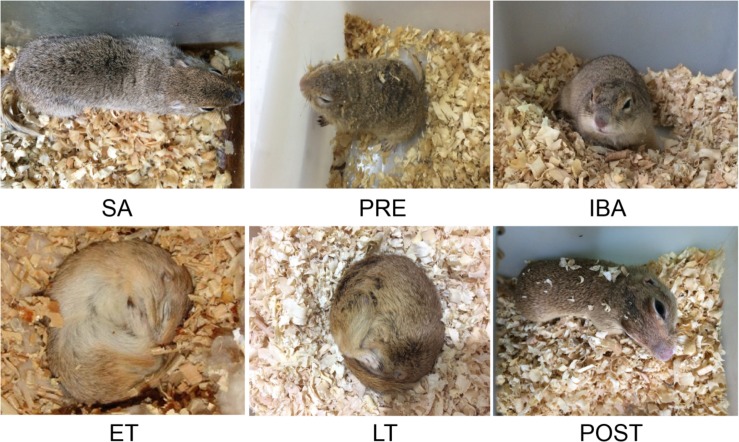
Images of Daurian ground squirrels during different hibernation periods. SA, summer active; PRE, pre-hibernation; ET, early torpor; LT, late torpor; IBA, interbout arousals; POST, post-hibernation.